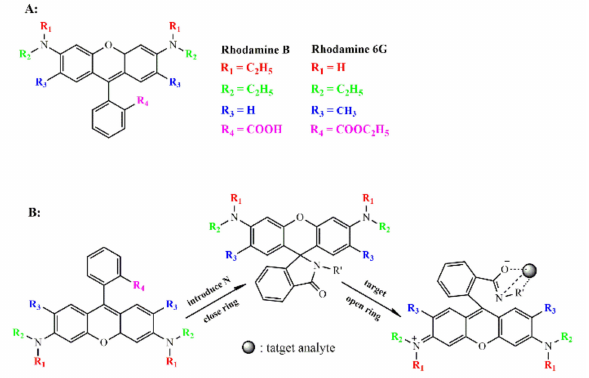
Figure 1. Chemical structures of rhodamine B and rhodamine 6G ( A ) and the general sensing principles of rhodamine-based sensors ( B